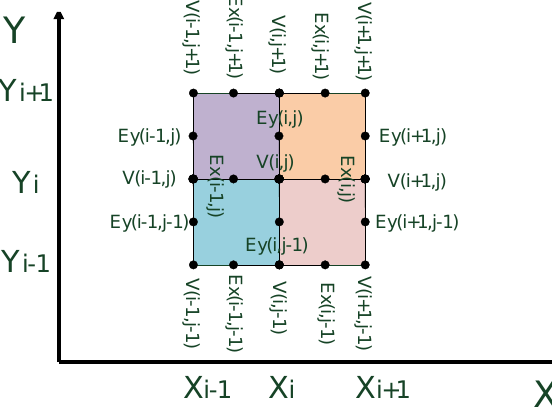
Figure 4. The electric field interaction of the proposed SEG